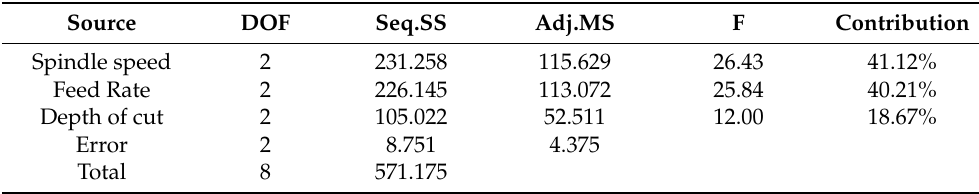
Table 4. ANOVA analysis for cutting force of 0 ◦ PCD tool.